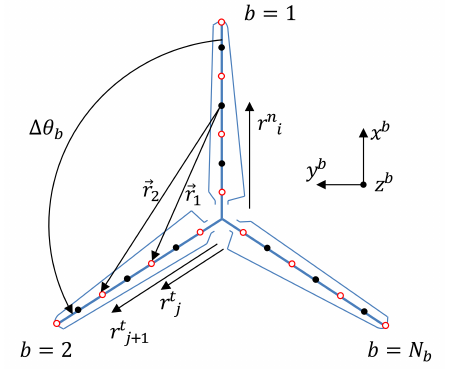
Figure 2. The blade bound vortex